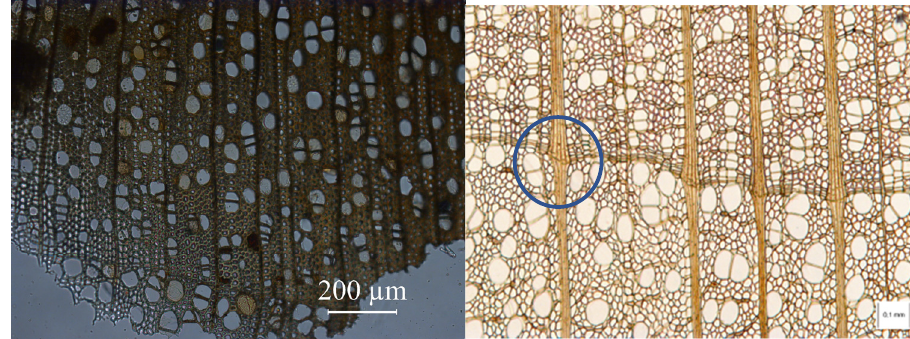
Figure 12. On the left is a cross-section of willow wood, and on the right, of limewood; the circle highlights the rays that widen crossing the ring limit.